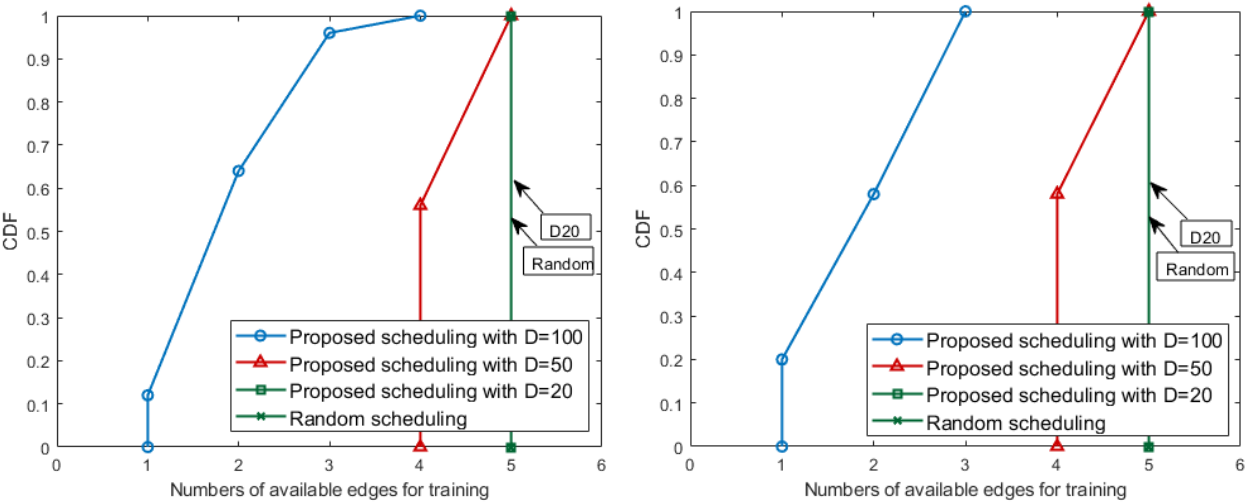
Figure 7. The numbers of available edges for training in Keum River: Baekjae barrage ( left ) and Gongju barrage ( right ).